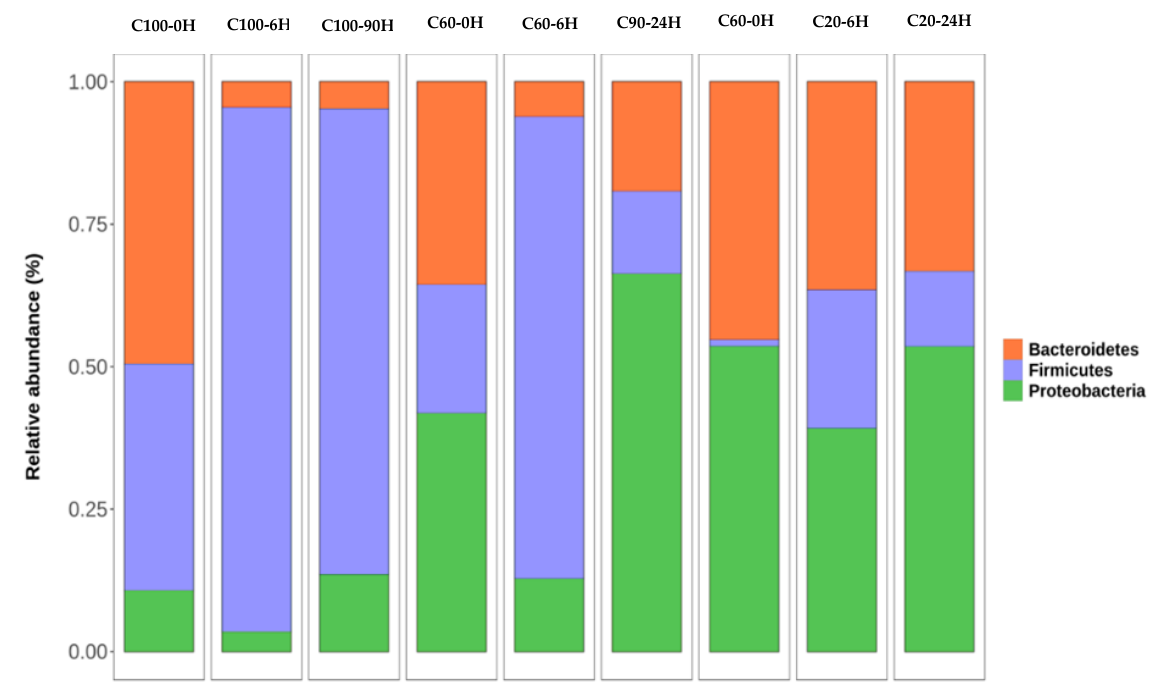
Figure 6 . Relative abundance of the main bacterial phyla of cactus forage and buffel grass hay levels at different times of exposure to air. C100 = 100% cactus forage; C60 = 60% cactus forage and 40% buffel grass hay; C20 = 20% cactus forage and 80% buffel grass hay; 0H = 0 h; 6H = 6 h and 24H = 24 h of exposure to air.